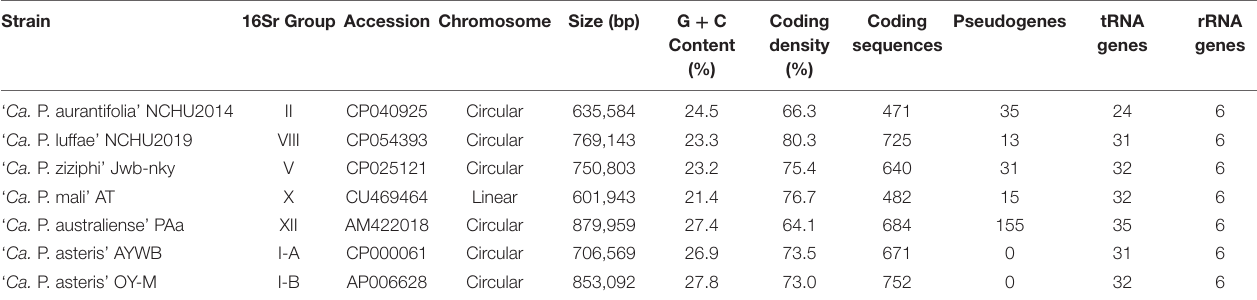
TABLE 2 | List of the representative phytoplasma genome sequences analyzed.